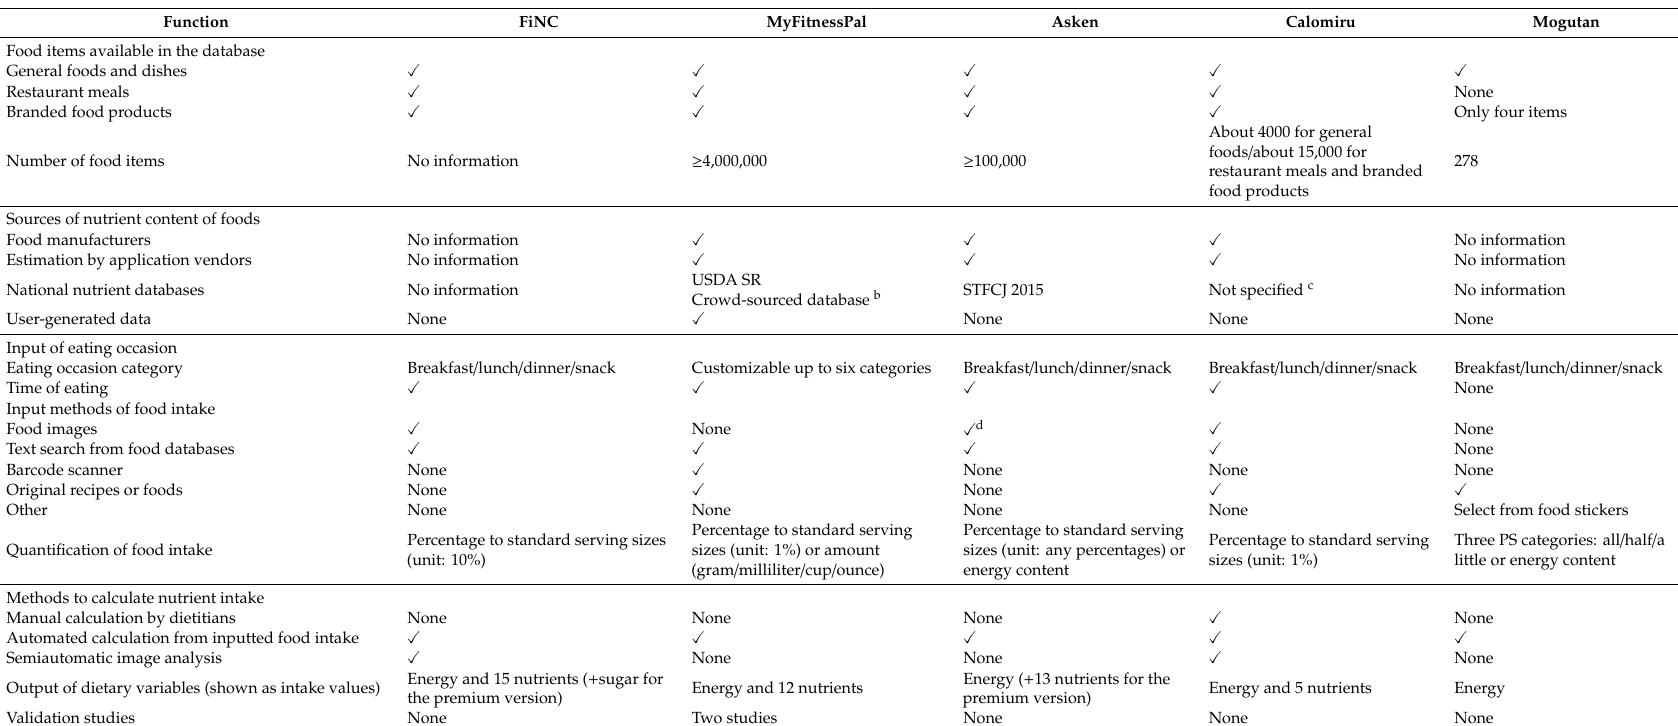
+ sugar for the premium